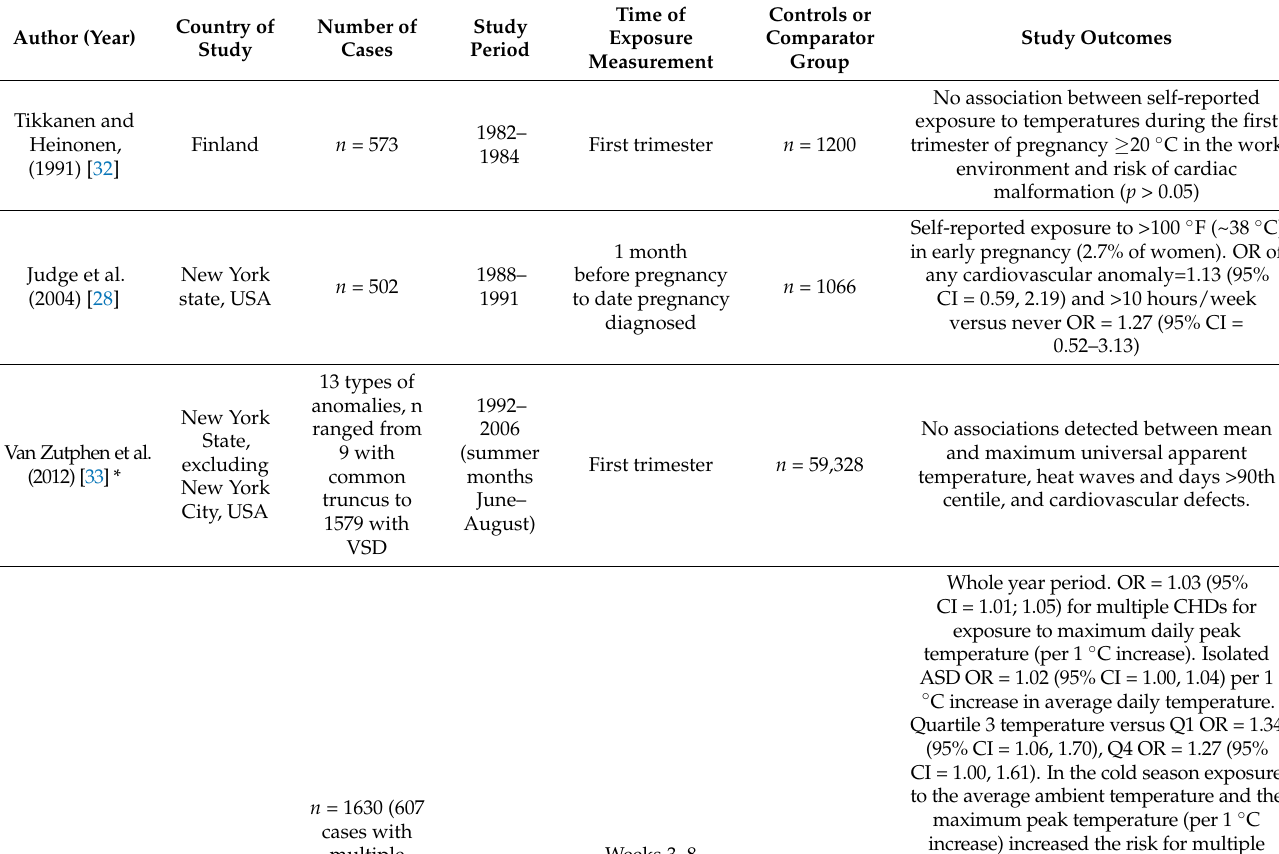
Table 1. Associations between heat exposure and congenital heart